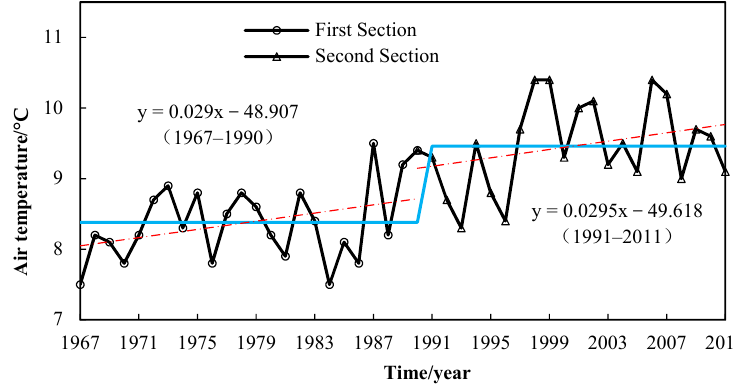
Figure 4. Average annual temperature and tendencies in the Lanhe Watershed. Water 2016 , 8 , 490